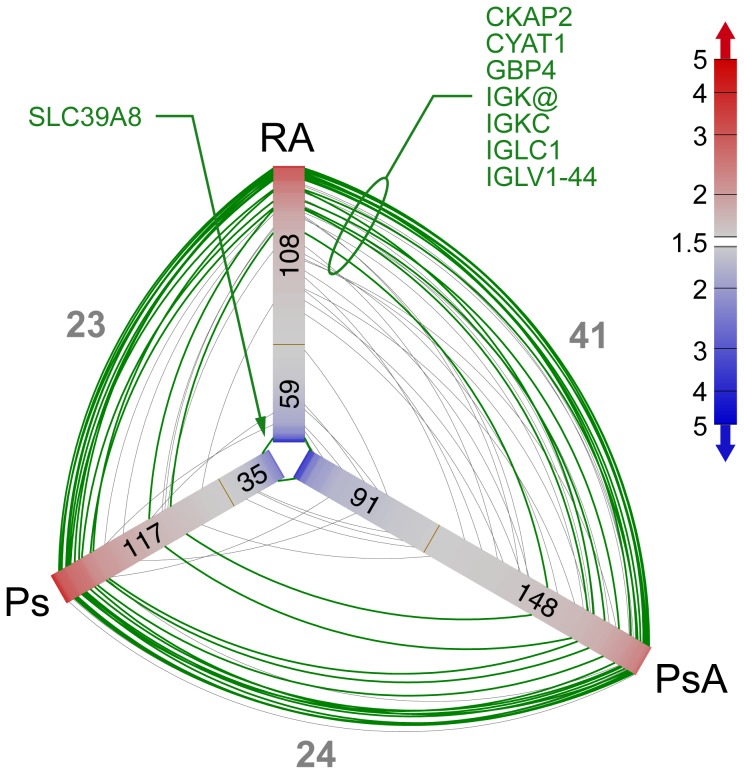
Venn/hive plots showing genes that changed following IFX treatment in three diseases in CD14+ cells.The three shaded bars emanating from the center each represent a list of significant probe sets where their members are distributed along the bar sorted by fold-change (indicated by color). The numbers of probe sets up- and down-regulated are shown on the red and blue portions of the bars, respectively. For example, in PsA,148 genes were up-regulated and 91 down-regulated following IFX therapy. Arcs that connect pairs of shaded bars represent genes that are common between two comparisons (in the same fashion, the intersect of two circles in a Venn diagram); the gray numbers indicate the numbers of arcs. Probe sets that are common to all three lists are represented by green arcs (15 probe sets representing eight genes). Probe set lists were obtained using a general linear model with p<.05, with the requirement that the log2 signal was required to be >5 for at least one of the sample groups and the absolute fold change was required to be greater than 1.5. Only annotated probe sets are depicted. For this figure, the larger fold change was used for the two time points after baseline.